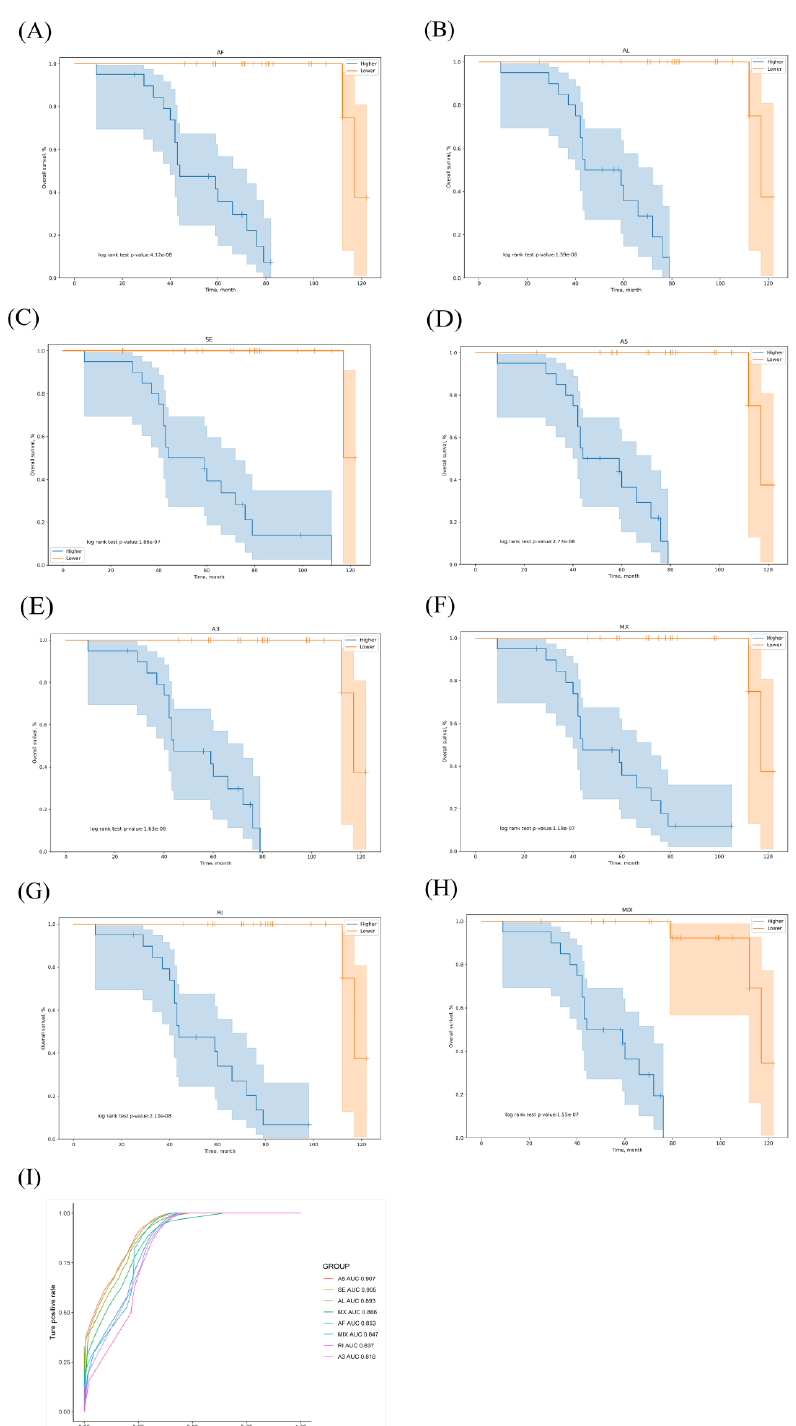
Figure 5. Kaplan–Meier and receiver operating characteristic (ROC) curves of the prognostic predictors in our LUAD cohort. ( A – G ) Kaplan–Meier curves of the prognostic predictors constructed for each type of AS event. Blue line indicates high-risk group; red line indicates low-risk group. ( H ) Kaplan–Meier curves of the mixture (MIX) prognostic predictor constructed for all types of AS events. ( I ) ROC analysis for all prognostic predictors. The colored lines of the ROC curves of the prognostic predictors represent di ff erent types of AS